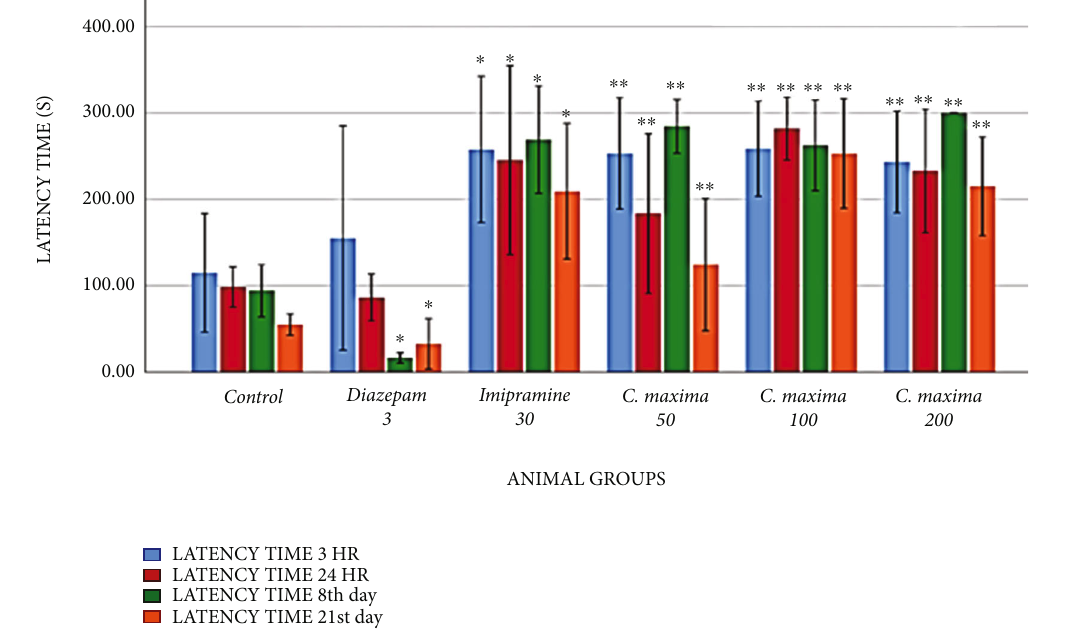
Figure 1: E ff ect of C. maxima on memory (passive avoidance test). Table 3: E ff ect of C. maxima seeds on the memory (water maze